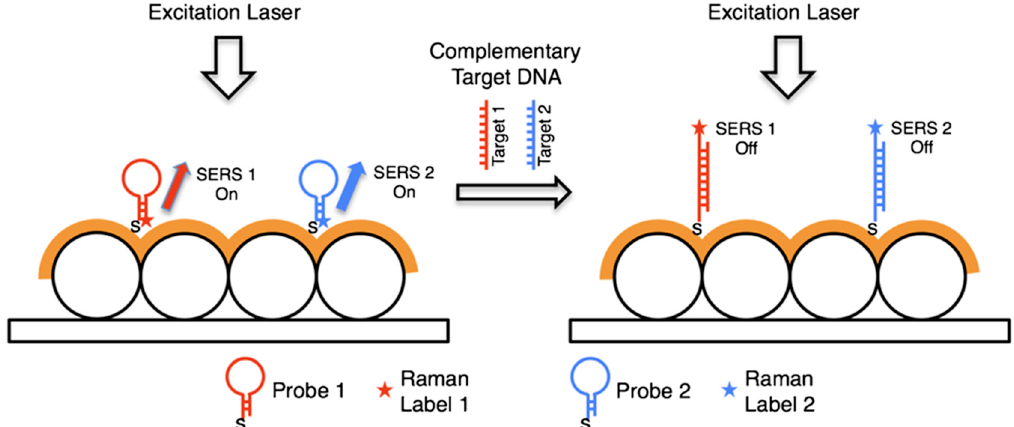
Figure 55. Schematic representation of the assay developed by the Vo-Dinh group employing the molecular sentinel (MS) approach. Reproduced with permission from Ngo et al. [66]. Copyright (2014), Springer-Verlag Berlin Heidelberg.